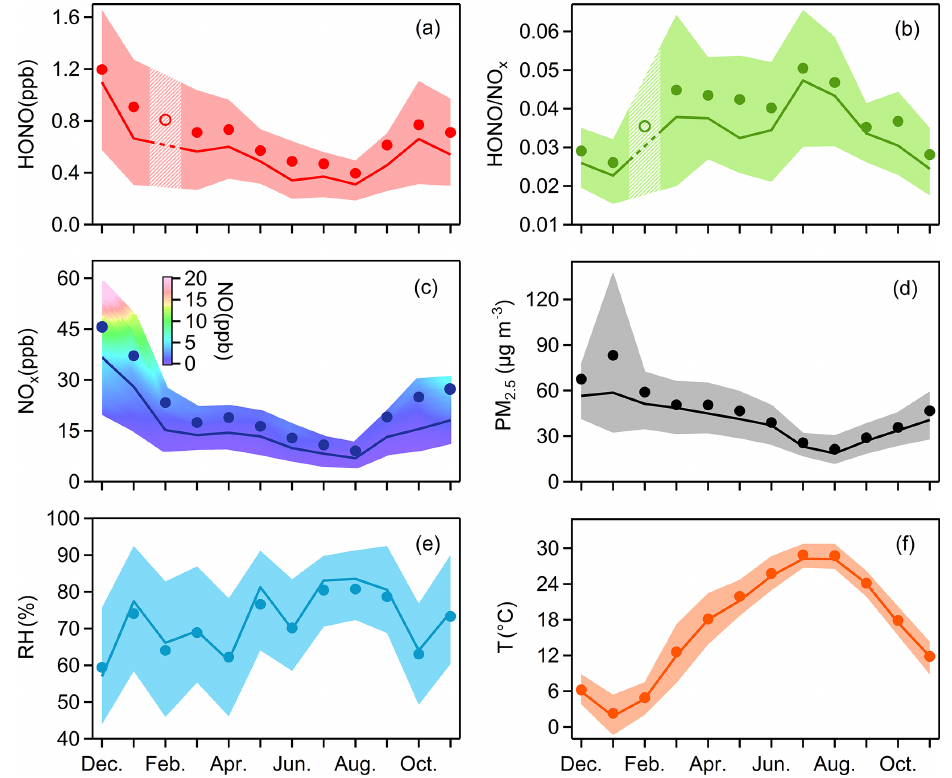
Figure 1. Monthly variations of (a) HONO, (b) HONO / NO x , (c) NO x , (d) PM 2 . 5 , (e) RH and (f) T . The solid bold lines are median values, the markers indicate mean values, and the shaded areas represent percentiles of 75% and 25%. In (a) and (b) , values in February are linearly interpolated based on the data from the months before and after, since there were only a few days when HONO was observed in February. In (c) , the shaded area is colored by the 25th to 75th percentiles of